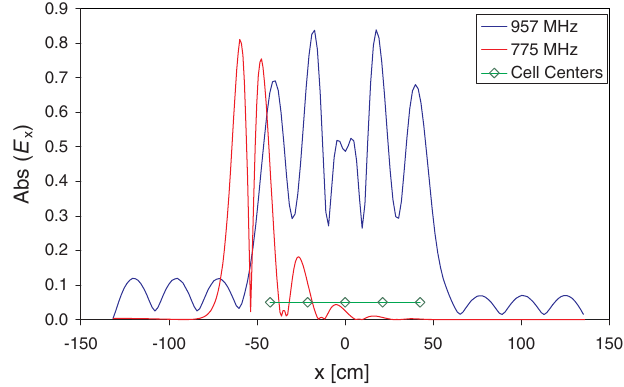
FIG. 4. Plots of the longitudinal electric field component at 1 cm off axis for a dipole beam tube mode (red), and for a quasitrapped mode (blue). The fields are plotted against the location of the cell centers.